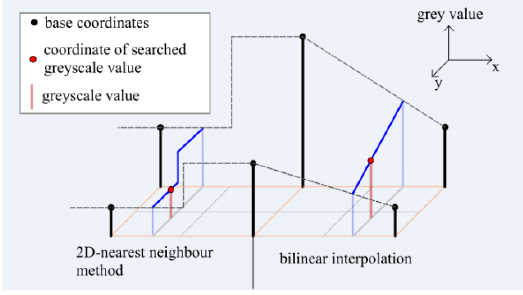
Figure 5. Comparing nearest-neighbor and bilinear inter- polation